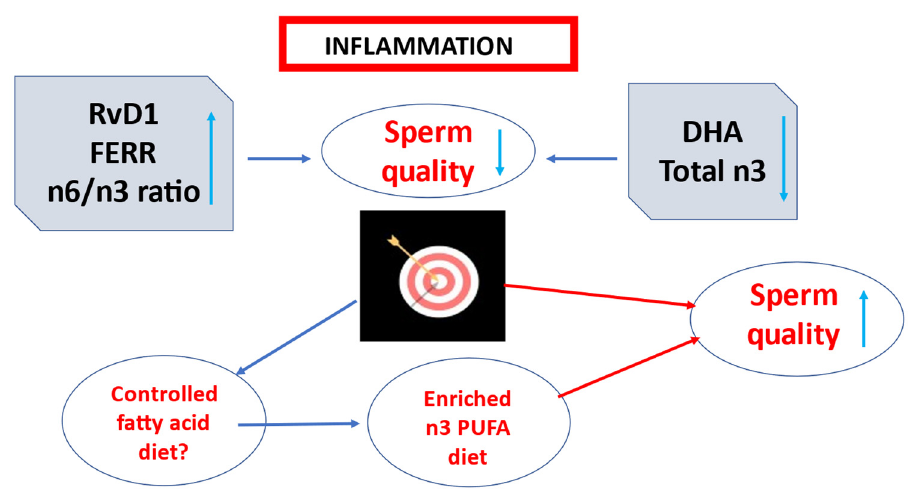
Figure 6. The conclusions of the study.